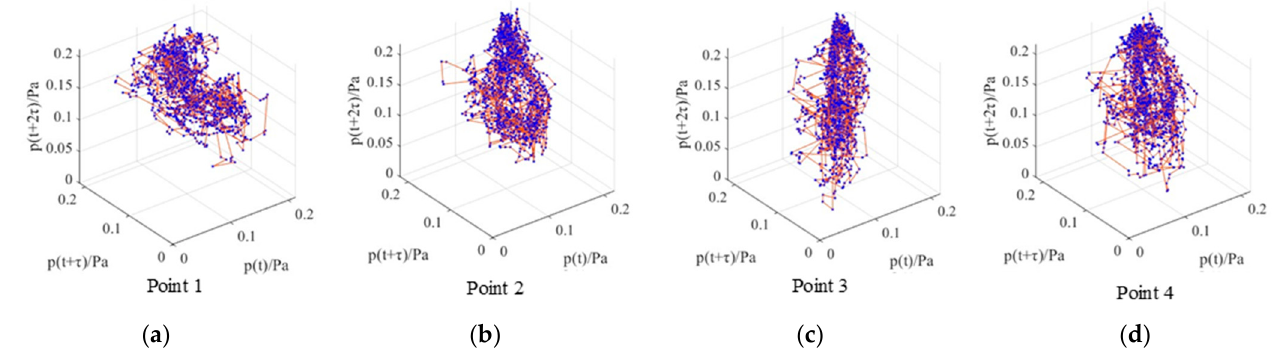
Figure 16. Phase space trajectories for A = 8 mm: ( a ) point 1; ( b ) point 2; ( c ) point 3; ( d ) point 4.